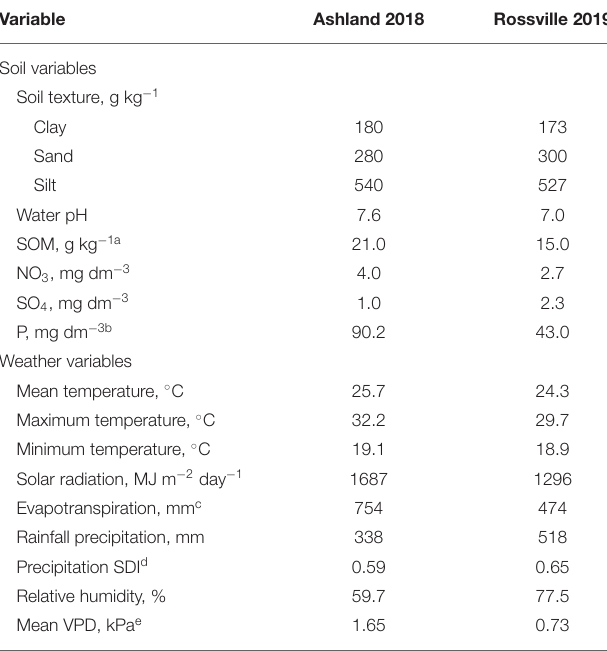
TABLE 1 | Soil and weather variables characterizing Ashland Bottoms 2018 and Rossville 2019 experimental sites.